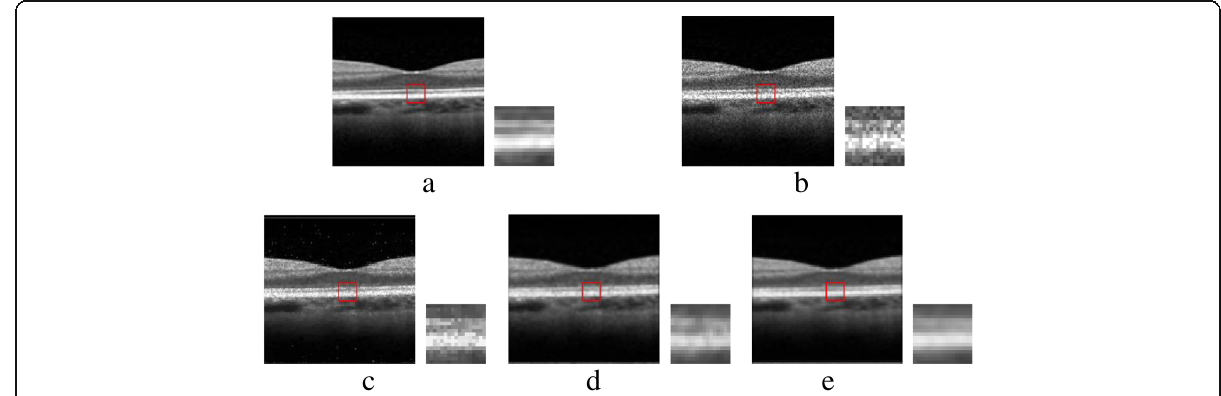
Fig. 7 Recovered OTC images and zoomed square region marked by red-lined boxes via different methods. a Original image, b noisy image (PSNR = 20.8433, SSIM = 0.6984), c nonlocal-AA method (PSNR = 21.5102, SSIM = 0.7621), d nonlocal-SO method (PSNR = 22.0345, SSIM = 0.8315), and e proposed method (PSNR = 22.4348, SSIM =